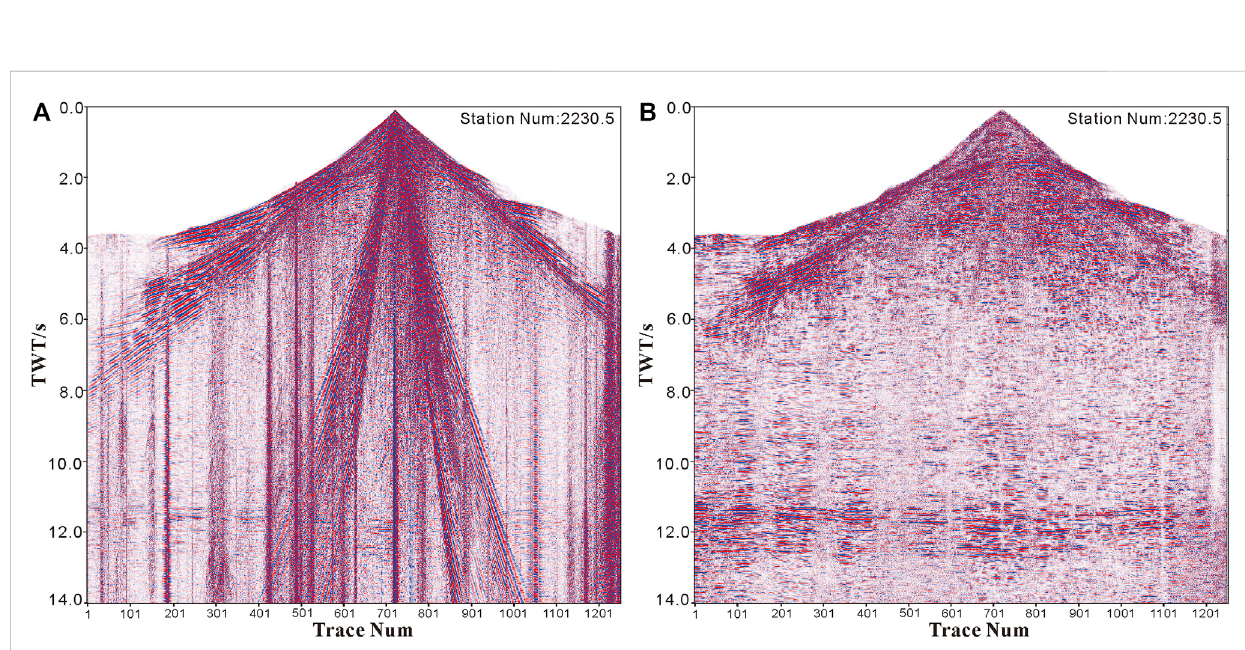
FIGURE 3 The comparison before and after noise attenuation. (A) The record before noise attenuation with time function gain. (B) The record after noise attenuation with the same time function gain.